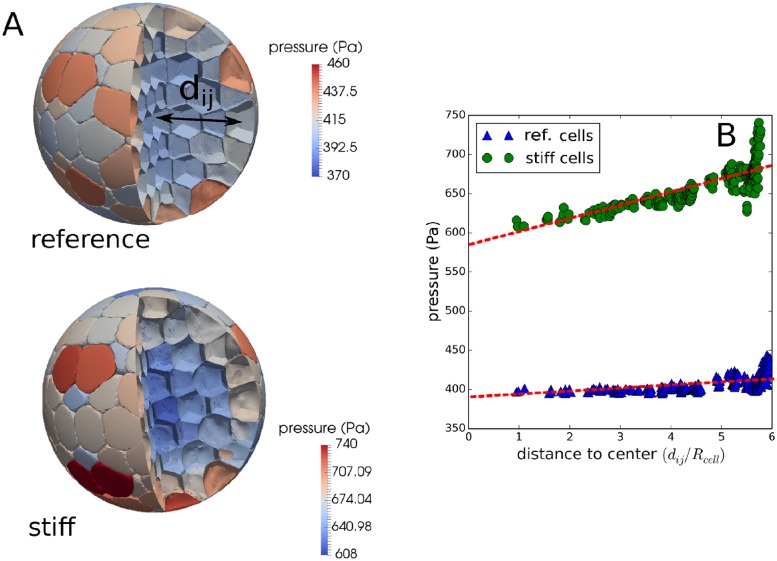
(A) Simulation snapshots of DCM cells within a scaled capsule model, for the cases of cells with a reference cortex stiffness (top) and a “stiff” cortex stiffness (bottom). The coloring is according to pressure (B) Internal cell pressure for deformable cells in a shrunk capsule for nominal cells and stiff cells, as function of distance to the capsule center. The stiff cell types show a gradient in cell pressure if moving from the spheroid center towards the edge (indicated by dashed red line), while a higher variability as compared to the softer types. Notice that like in the calibration simulations we use cells of equal volume prior to compression but the method can equally be applied to any prior volume distribution.